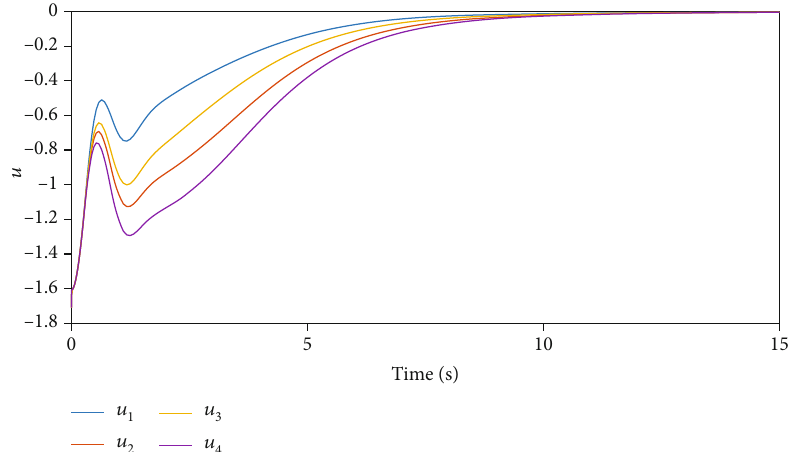
Figure 5: Control input u with deadzone.